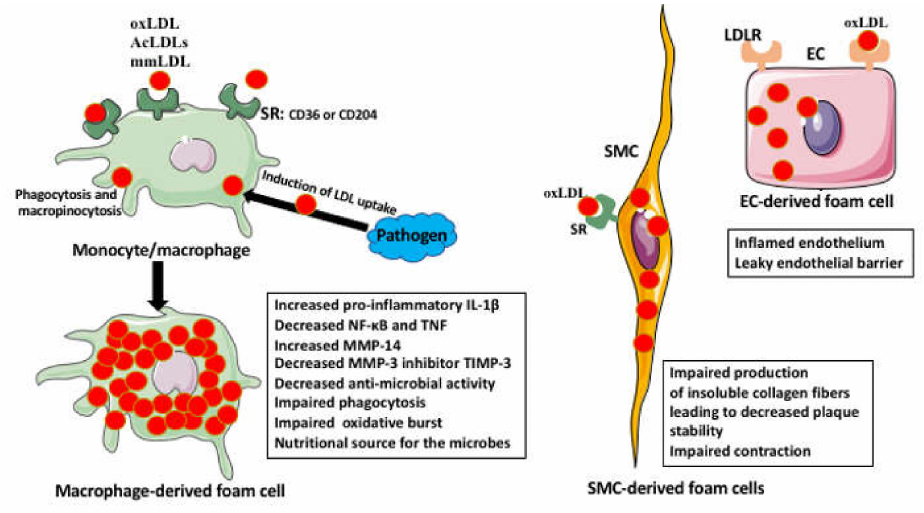
Figure 3. Types of foam cells and effects on cell functions. The macrophage-derived foam cells form from the monocytes/macrophages, which uptake various forms of LDLs (oxLDL, AcLDL, and mmLDL) through the SRs such as CD36 or CD204, phagocytosis or macropinocytosis. The LDL uptake can be also induced by various pathogens. The lipid-laden macrophages (the foam cells) have lowered the production of some of the pro-inflammatory cytokines, impaired phagocytosis, motility, and anti-microbial activity. They also have increased metalloproteinase and decreased metalloproteinase inhibitor production, which can lead to plaque instability. The foam cells can also derive from other cell types such as smooth muscle cells (SMCs) and endothelial cells EC. The SMCs uptake LDL via SR receptors. The lipid-laden SMCs have impaired contraction and impaired production of insoluble collagen fibers, which can lead to decreased plaque stability. The ECs uptake LDLs via various LDL receptors (LDLR). The lipid-laden endothelial cells become inflamed and are unable to properly adhere to each other, which leads to the leakiness of the endothelial barrier. The leaky endothelial barrier becomes permeable for lipids and immune